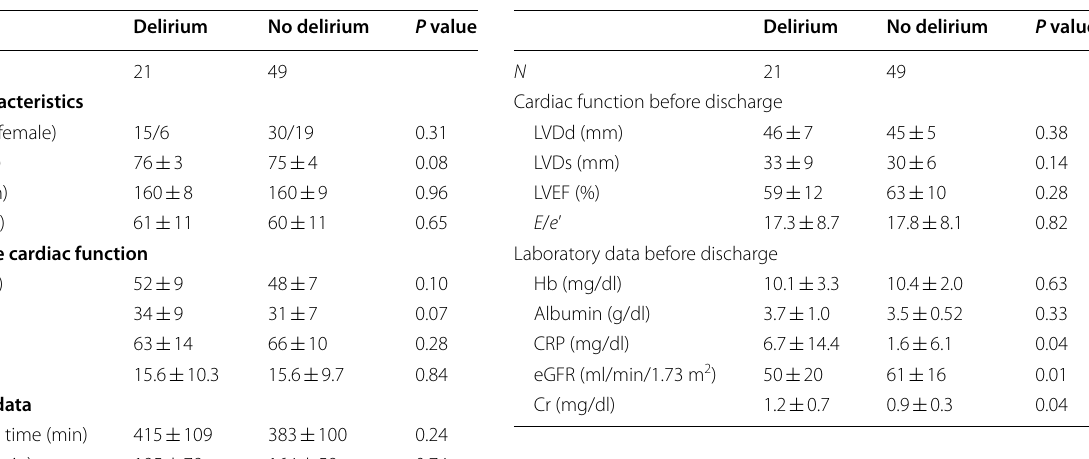
Table 3 Data before discharge from our hospital in each